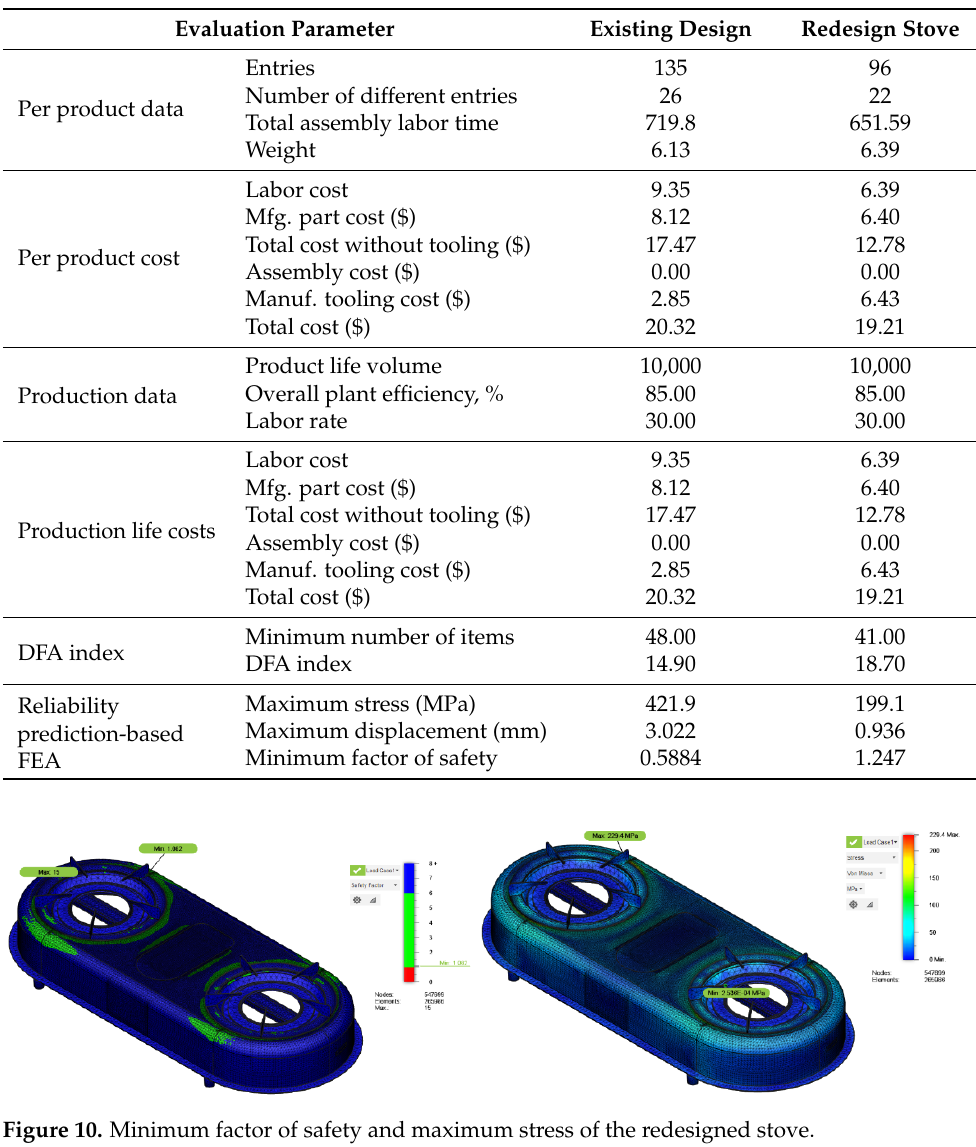
Table 6. Comparative analysis of the redesigned and existing stoves.